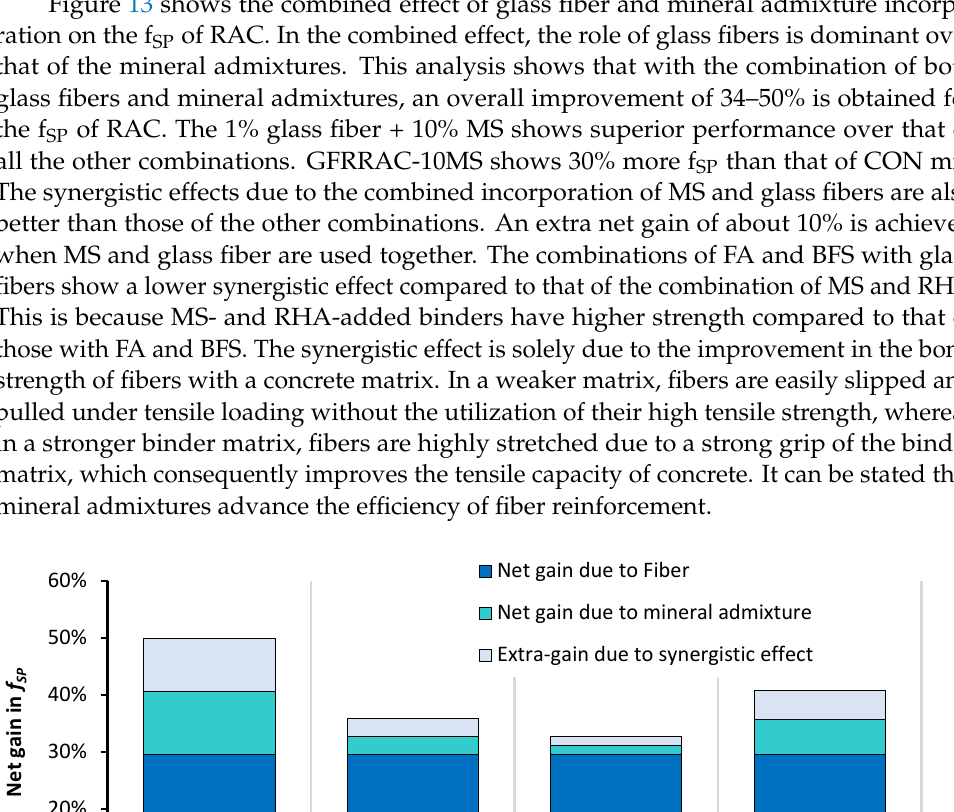
Figure 12. The net change in f SP of PRAC and GFRRAC due to the addition of mineral admixtures (MS, BFS, FA, and RHA).